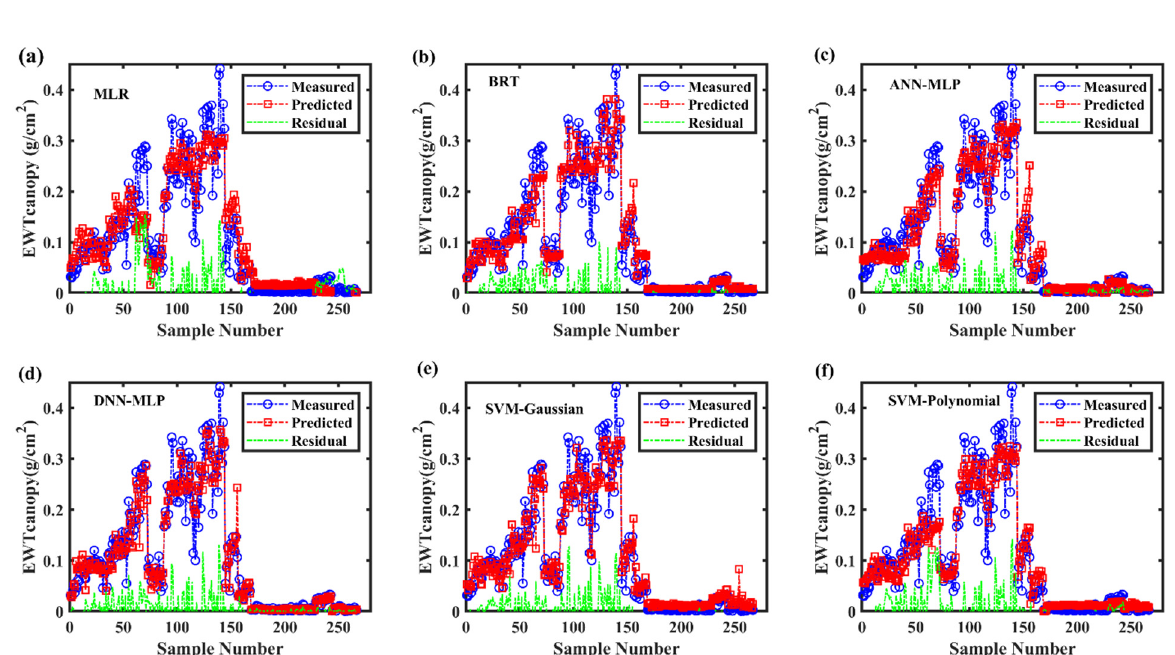
Figure 8. Comparative plots between EWT canopy values predicted using multiple linear regression (MLR, a ), boosted regression tree (BRT, b ), artificial neural network (ANN, c ), deep neural network (DNN, d ), support vector machine Gaussian (SVM-Gaussian, e ), and support vector machine polynomial (SVM-Polynomial, f ) models and the measured EWT canopy values from all